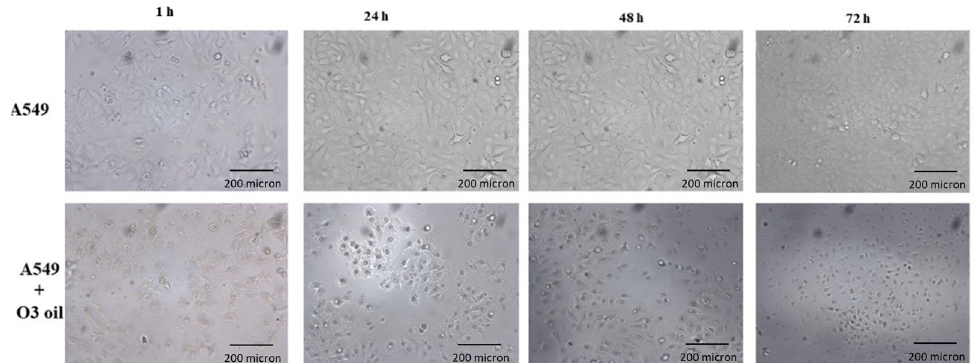
Figure 2. Time-dependent in vitro growth of A549 lung cancer cells either sham-treated with sun- flower oil (upper row) or treated with ozonide oil >700 ozonides with a percentage v / v of ozonized oil related to sunflower of 97% (lower row). Sham-treated cells grow rapidly reaching semi-confluence at 24 h and full confluence at 48 h. Cancer cells treated with ozonide oil already display impaired growth during the first 24 h. After this time, they rapidly undergo time-related increasing cell death, culminating at 72 h.